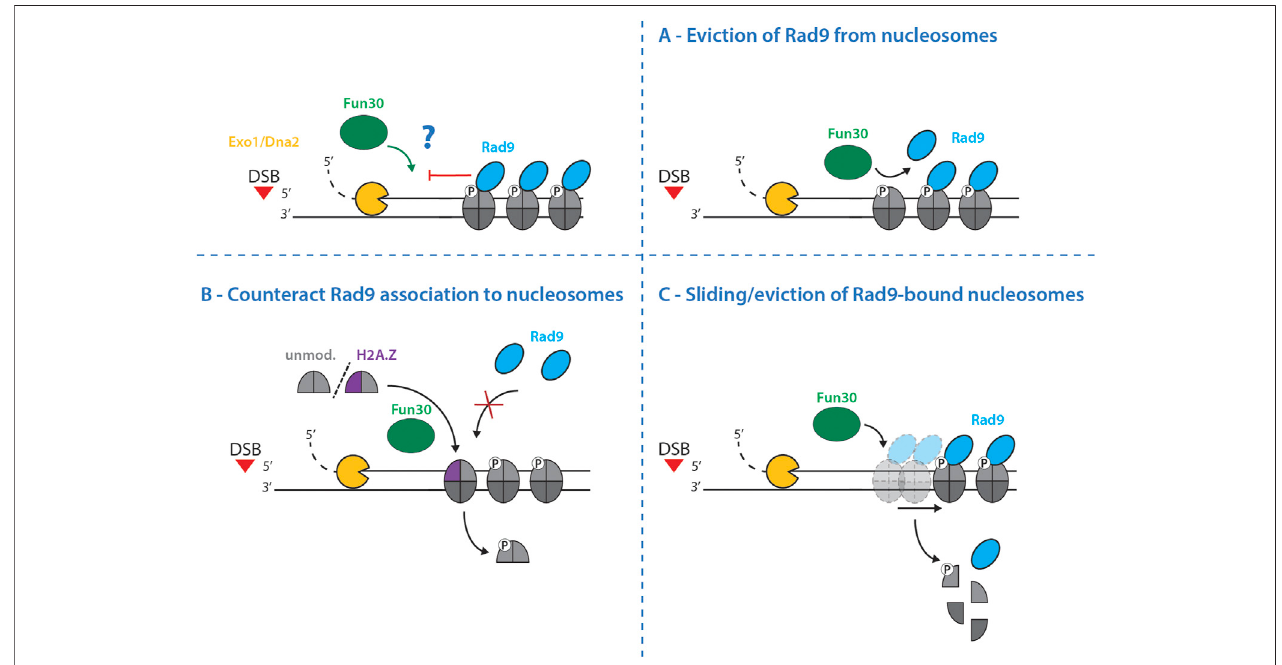
FIGURE 4 | Potential mechanisms by which Fun30 may promote resection. Long-range resection is controlled by the antagonism between the resection- promoting nucleosome remodeler Fun30 and the resection-inhibiting nucleosome binder Rad9. The precise mechanism of this antagonistic relationship is still elusive, but the following models are possible: (A) – Fun30 directly removes Rad9 from nucleosomes thereby removing the factor inhibiting resection. (B) – Fun30 counteracts Rad9 association with nucleosomes by exchanging histone dimers. It either incorporates histones lacking modi fi cations necessary for Rad9 association –